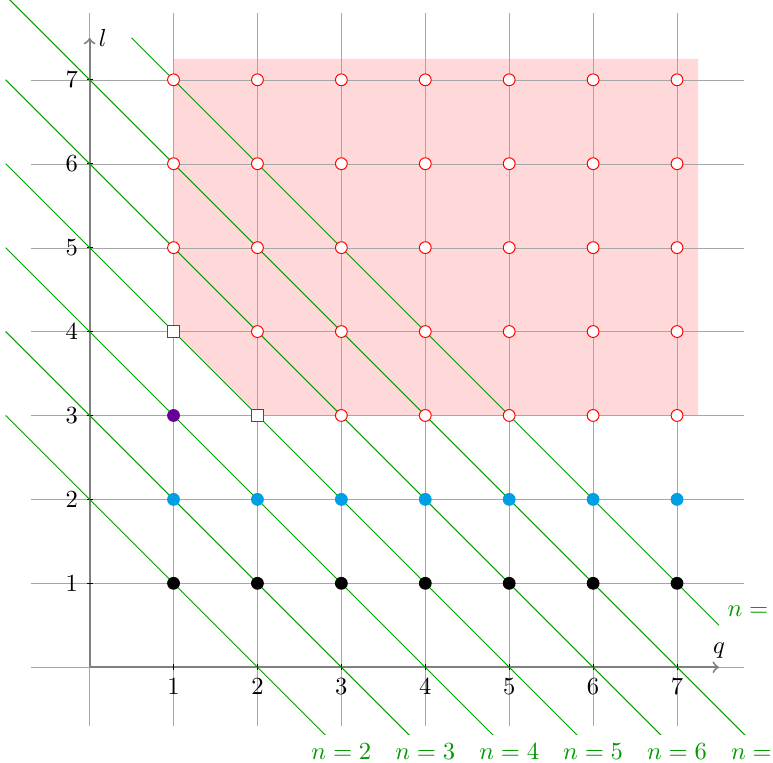
Figure 4 . Allowed values of ( q; l ) that lead to a (cid:12)nite E solid circles. The light red region contains disallowed values of ( q; l ) due to the divergence of the transverse energy arising from the nonabelian interactions of the gauge (cid:12)eld, see eq. (4.4). The open squares represent values where the E exponential. Remember that n = q + l and that q The Frobenius indices are (cid:11) + = 2 and (cid:11) (cid:0) = 2